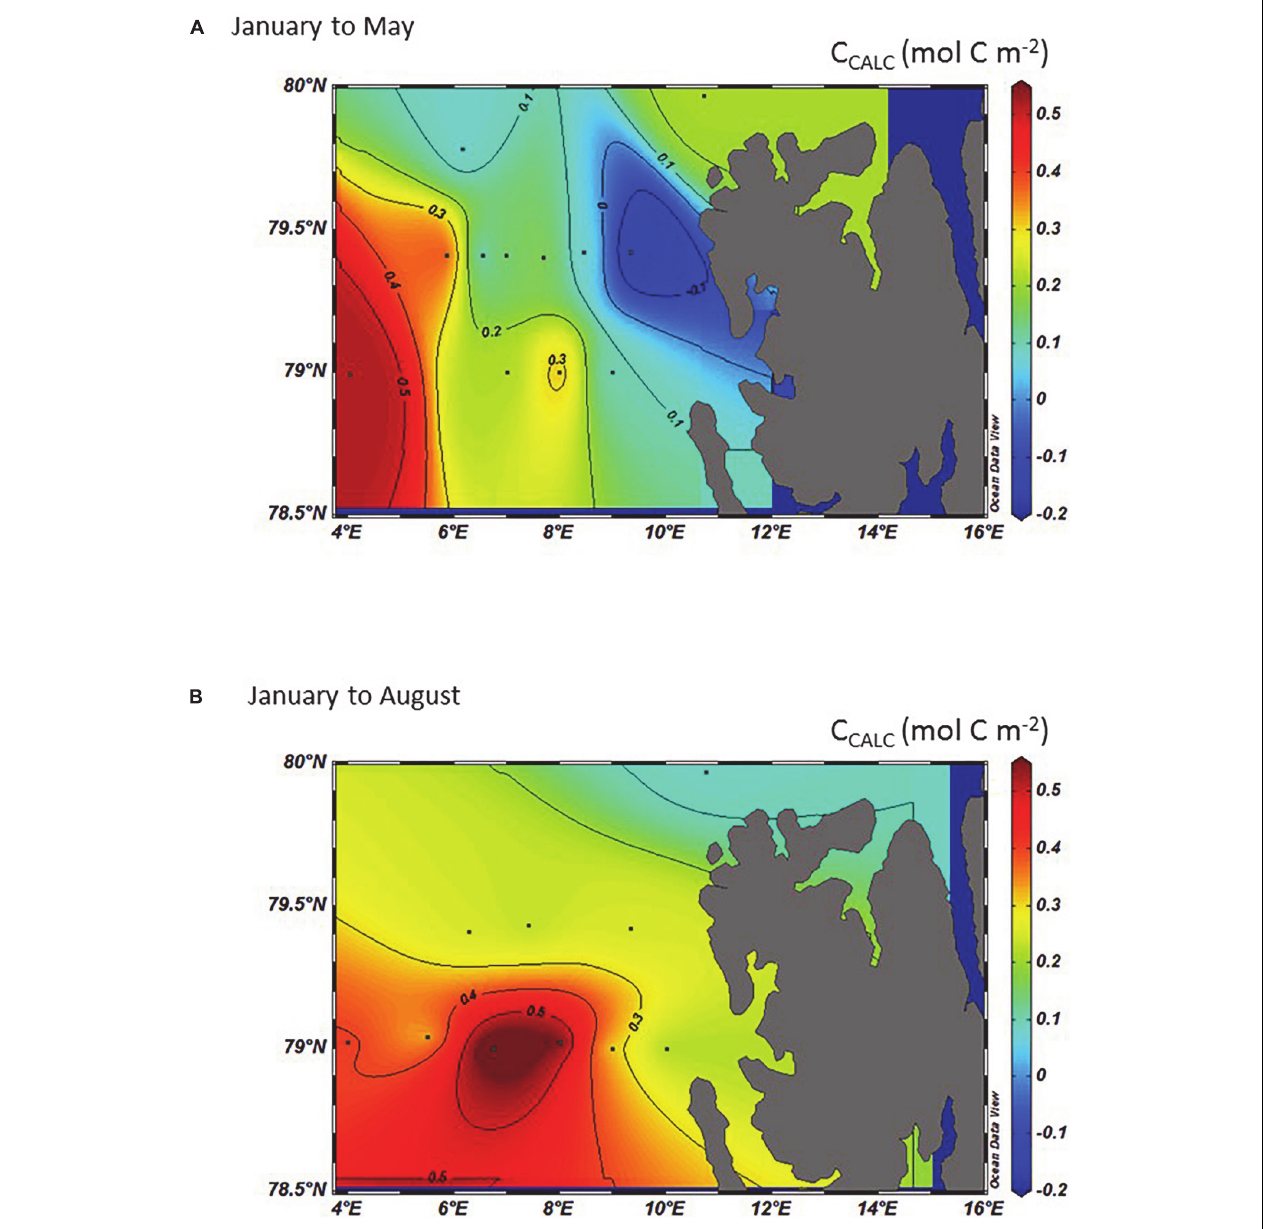
FIGURE 10 | The interpolated and integrated C CALC in the top 50 meters (mol C m − 2 ) in 2014 calculated from the difference between January and: (A) May and, (B) August 2014. Positive values denote a gain in DIC through CaCO 3 dissolution and negative values a loss through formation of CaCO 3